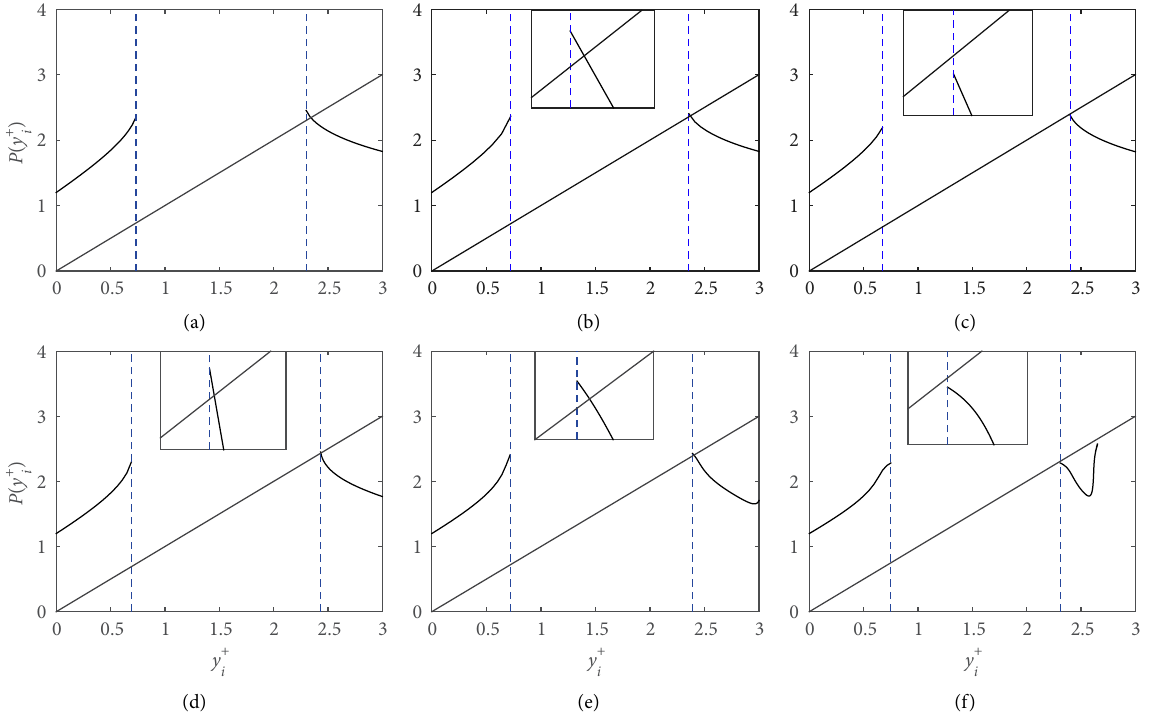
. (a) , (b) , (c) , (d) , (e) 훽 = 0 훽 = 0.1 훽 = 0.2 훽 = 0.4 ( 𝐶 2 ) , , , , , , , , 푞 = 1.3 푝 = 0.8 푐 = 1.8 휆 = 0.52 휔 = 0.1 푟 = 0.23 훿 = 0.3 휏 = 1.2